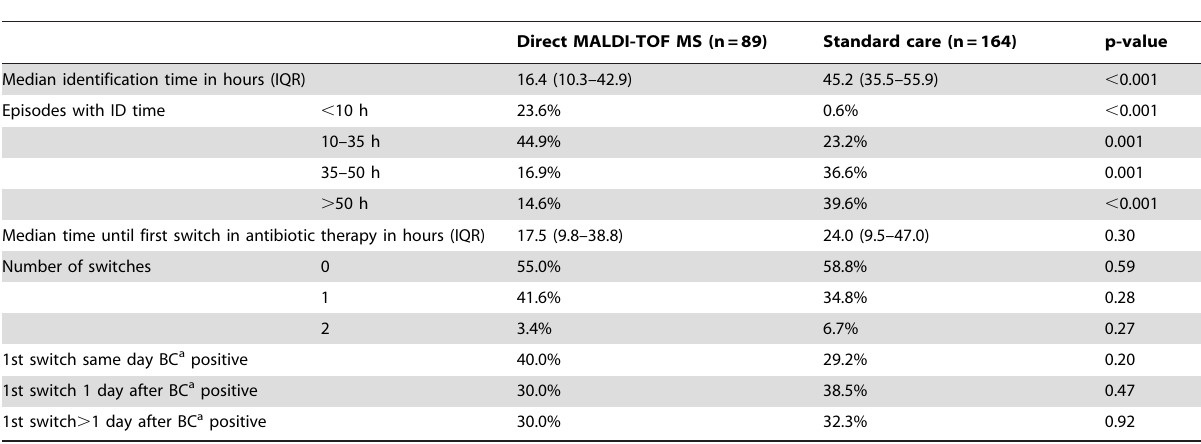
Table 3. Effect of direct MALDI-TOF MS on identification time and antibiotic switching.